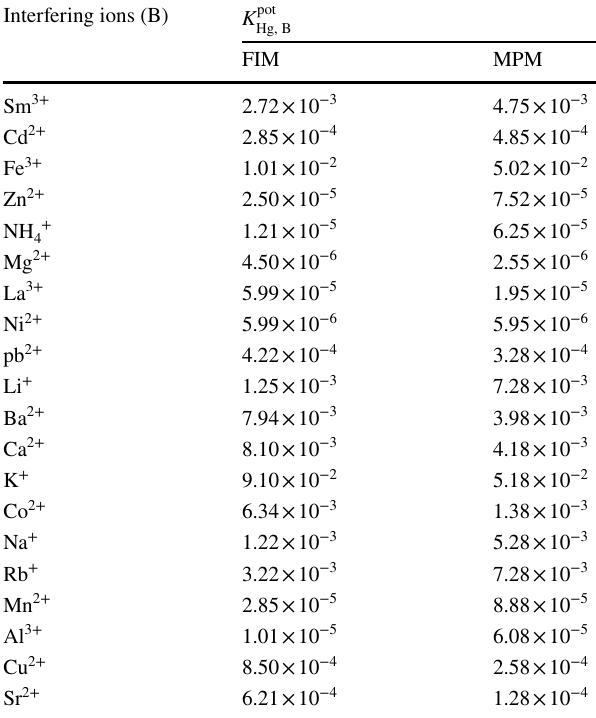
Table 2 Potentiometric selectivity coefficients of some interfering ions using the modified SPE sensor Interfering ions